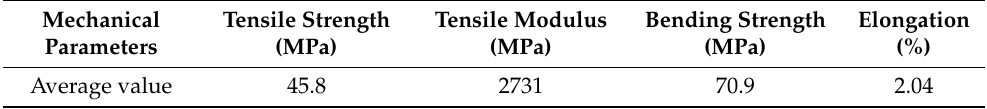
Table 1. Mechanical parameters of epoxy